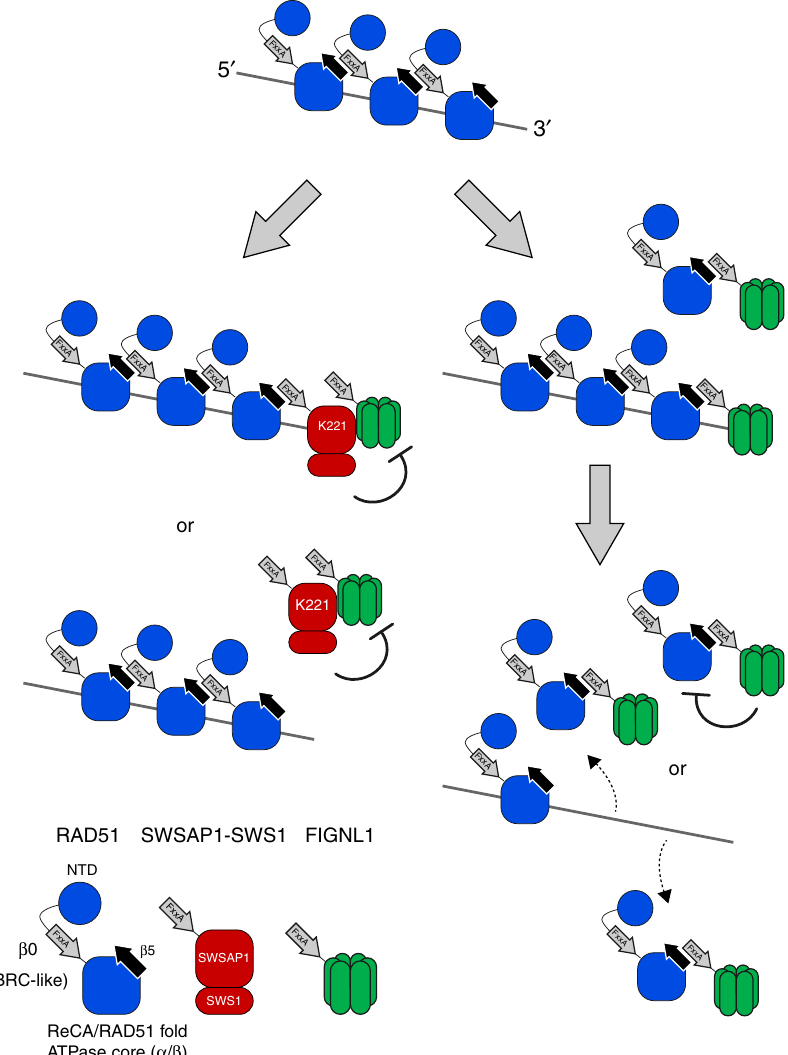
Fig. 7 Model showing the regulation of RAD51 assembly by SWSAP1 and FIGNL1. (Right) FIGNL1 promotes the dissociation of RAD51 fi lament to prevent inappropriate HR. FIGNL1 binds to RAD51 through its conserved FxxA motif and facilitates RAD51 dissociation by inducing the conformational change of RAD51 or enhancing ATP hydrolysis of RAD51. (Left) SWSAP1 stabilizes RAD51 fi lament from anti-recombinase FIGNL1. SWSAP1 binds to RAD51 fi lament through its conserved FxxA motif. SWSAP1 interacts with FIGNL1 through C-terminus and inhibits FIGNL1 ’ s RAD51- fi lament disruption activity in the solution and/or at the end of